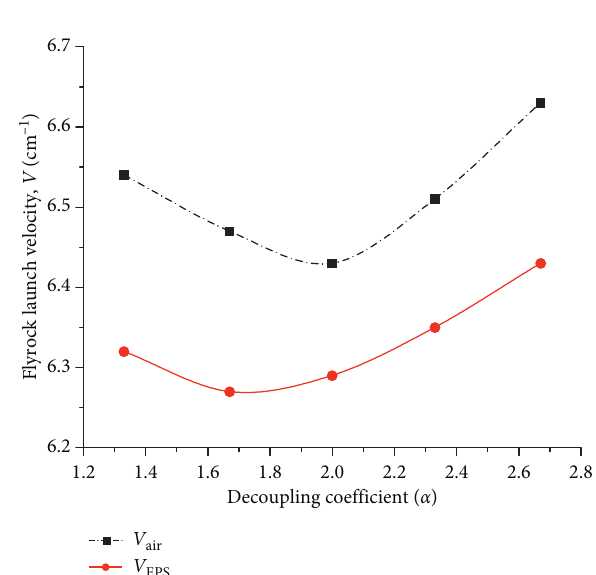
Figure 8: Relationship between the flyrock launch velocity and the decoupling